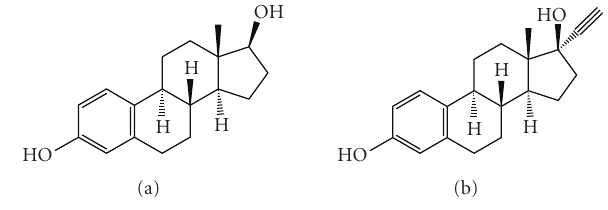
Figure 1: Molecular structures of E2 (a) and EE2